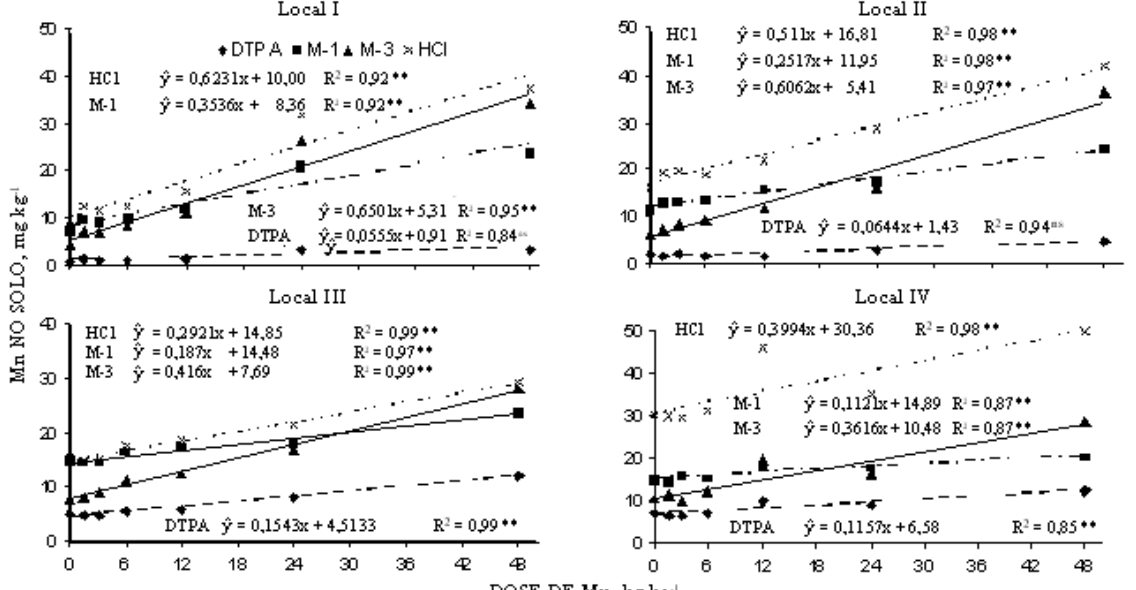
Figura 6. Teores de manganês do solo, extraídos com diferentes extratores (DTPA-TEA pH 7,3, M-1 = Mehlich- 1, M-3 = Mehlich-3 e HCl 0,1 mol L -1 ), dos quatro locais, considerando as doses de manganês aplicadas. Local I: Faz. Santa Rosa; Locais II e III: Faz. Novo Horizonte; Local IV: Campo Experimental da